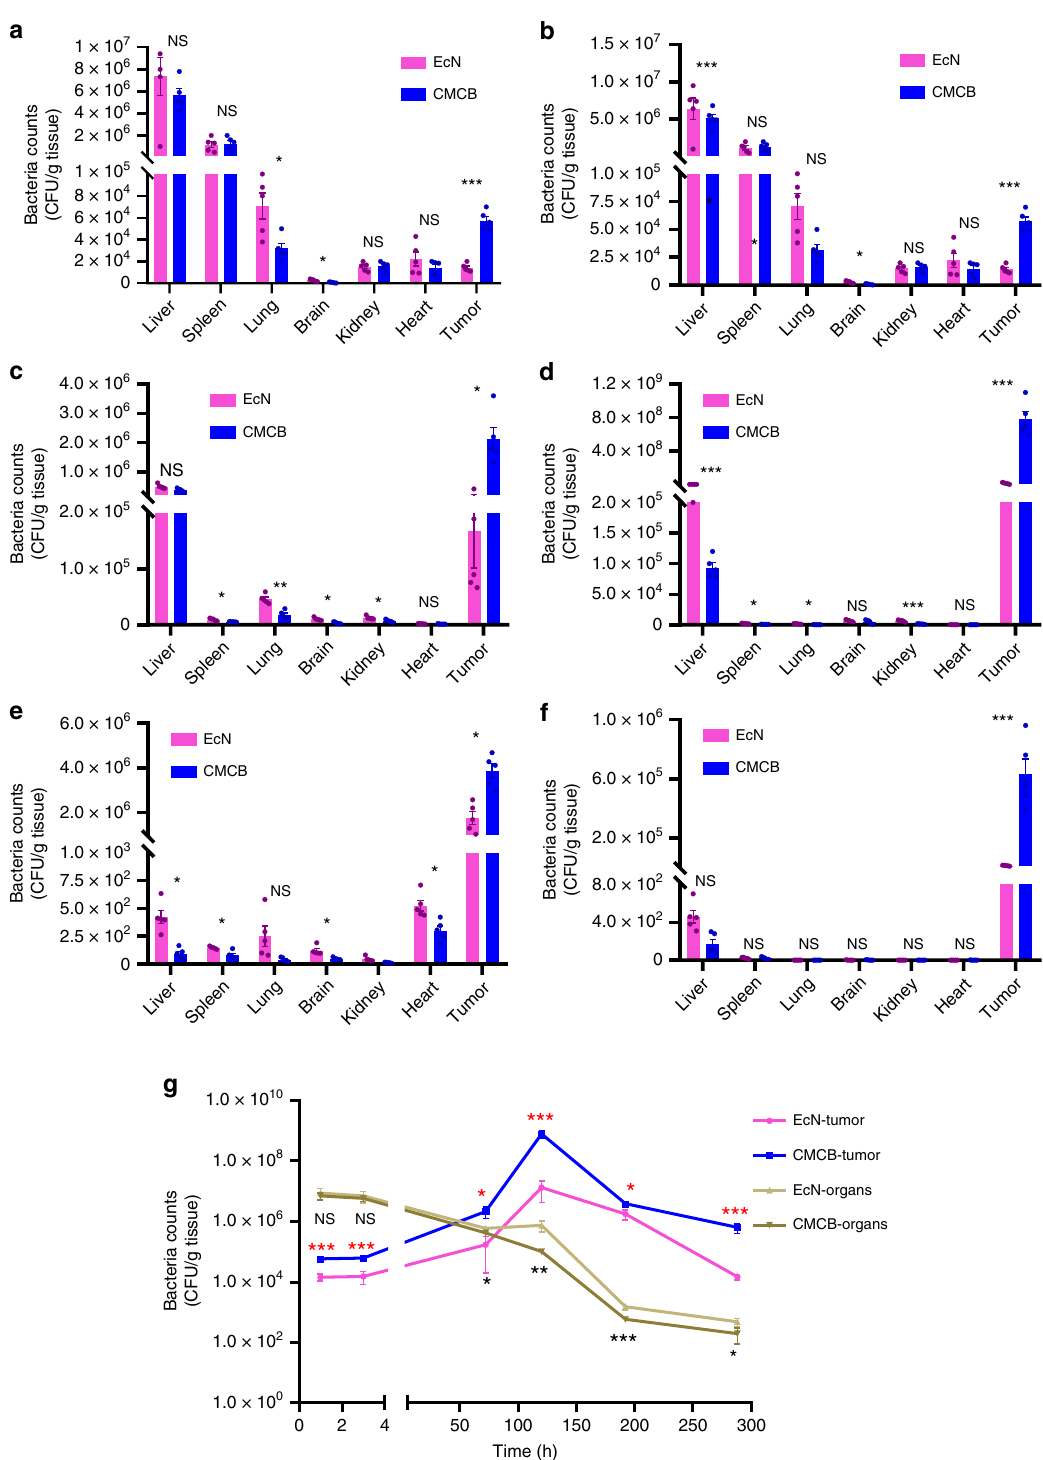
Fig. 4 Biodistribution of bacteria in tumor-bearing mice. 4T1 tumor-bearing mice with tumor volume around 50 mm 3 were intravenously injected with EcN or CMCB (1 × 10 7 CFUs) and then sacri fi ced at indicated time points. Organ homogenates were diluted and cultured on LB agar plates at 37 °C for 24 h prior to enumeration. Biodistribution at a 1 h, b 3 h, c 3 days, d 5 days, e 8 days, f 12 days post-injection, respectively. g The relationship between time post- injection and bacterial number within normal organs and tumor. Error bars represent the standard deviation ( n = 5). Signi fi cance was assessed using Student ’ s t -test, giving p -values, * p < 0.05, ** p < 0.01, *** p < 0.005. NS no signi fi